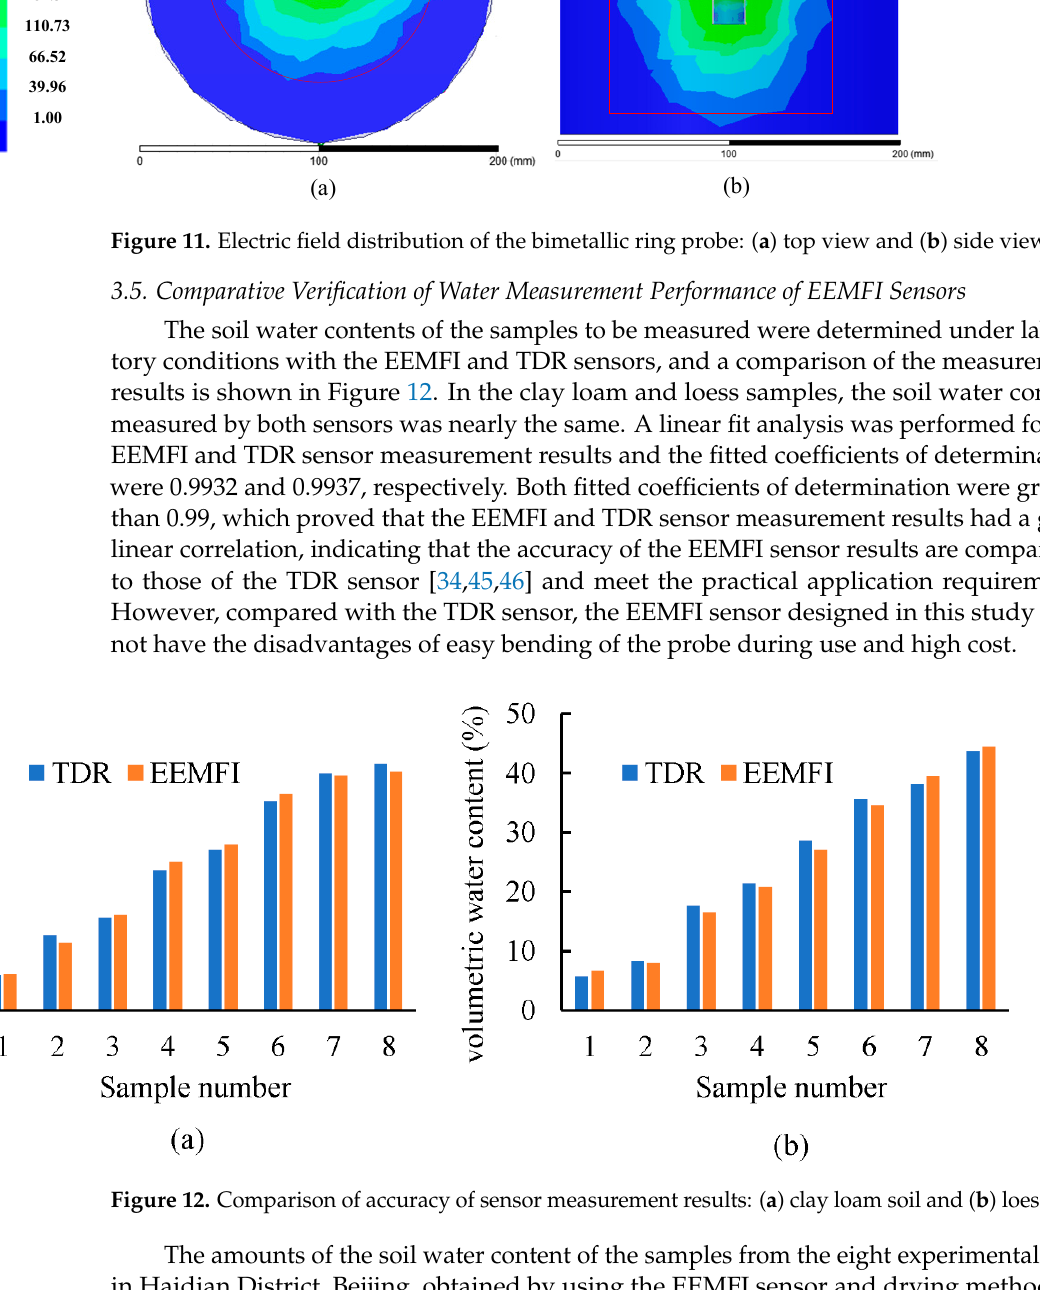
Table 7. Comparison of measurement results between EEMFI sensor and drying method.